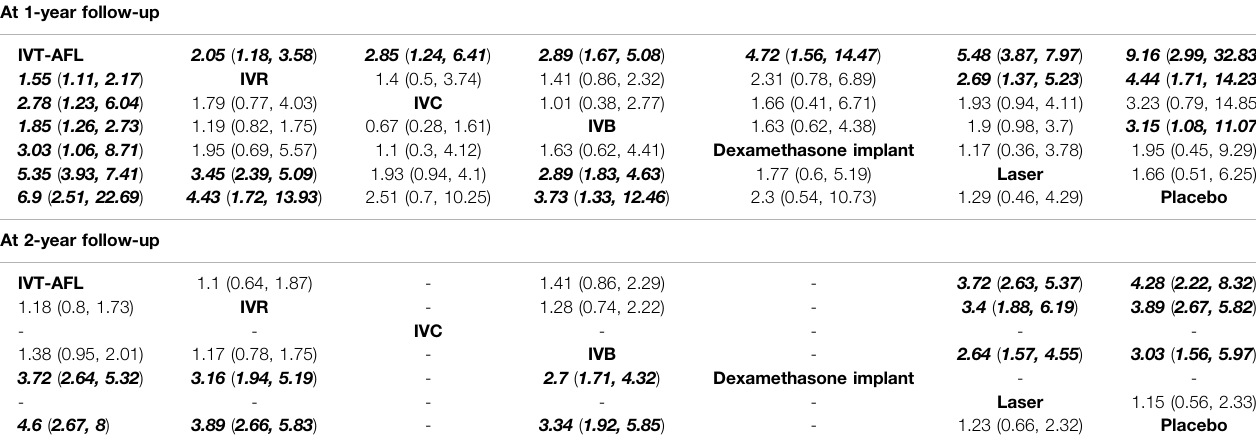
TABLE 3 | ORs with 95% CrIs of network meta-analysis for the proportion of patients with a gain of at least 15 ETDRS letters. At 1-year